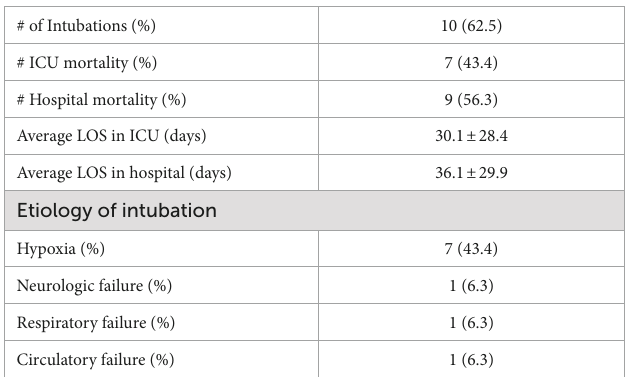
TABLE 4 Patient